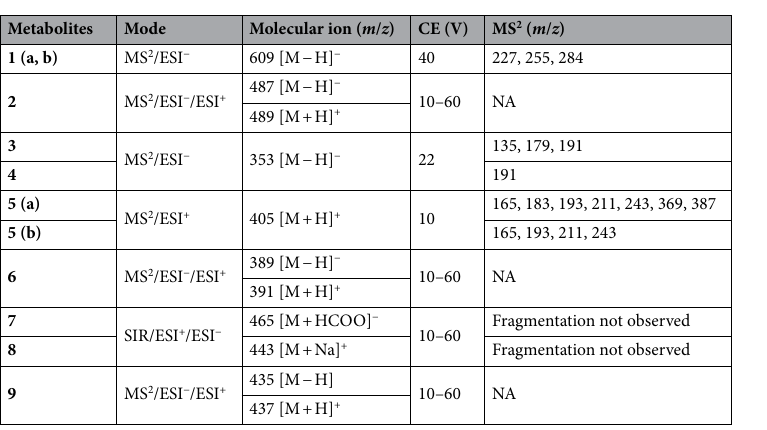
Table 1. Liquid chromatography coupled to mass spectrometry (LC–MS/MS) analysis of aqueous ethanolic extract of leaf from Citronella gongonha Mart. Howard (Cardiopteridaceae). Metabolites: 1a, b , kaempferol- 3- O -dihexoside; 2 , caffeoyl glucoside; 3 , 3- O -caffeoylquinic acid; 4 , 5- O -caffeoylquinic acid (confirmed with authentic standard compound); 5 ( a , b ), kingiside epimers; 6 , 8-epi-kingisidic acid; 7 , (7 α )-7- O - methylmorroniside; 8 , (7 β )-7- O -methylmorroniside; 9 , alpigenoside. MS 2 , mass fragmentation; SIR, single ion reaction; ESI + , electrospray ionization in positive mode; ESI − , electrospray ionization in negative mode. NA: Data not conclusive due to the lack of standard or MS/MS information in